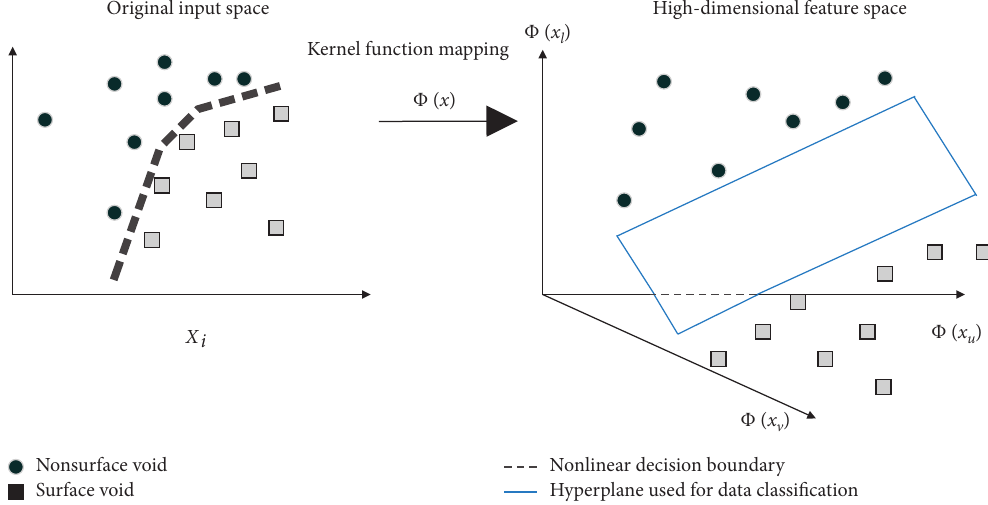
Figure 3: Demonstration of an SVM